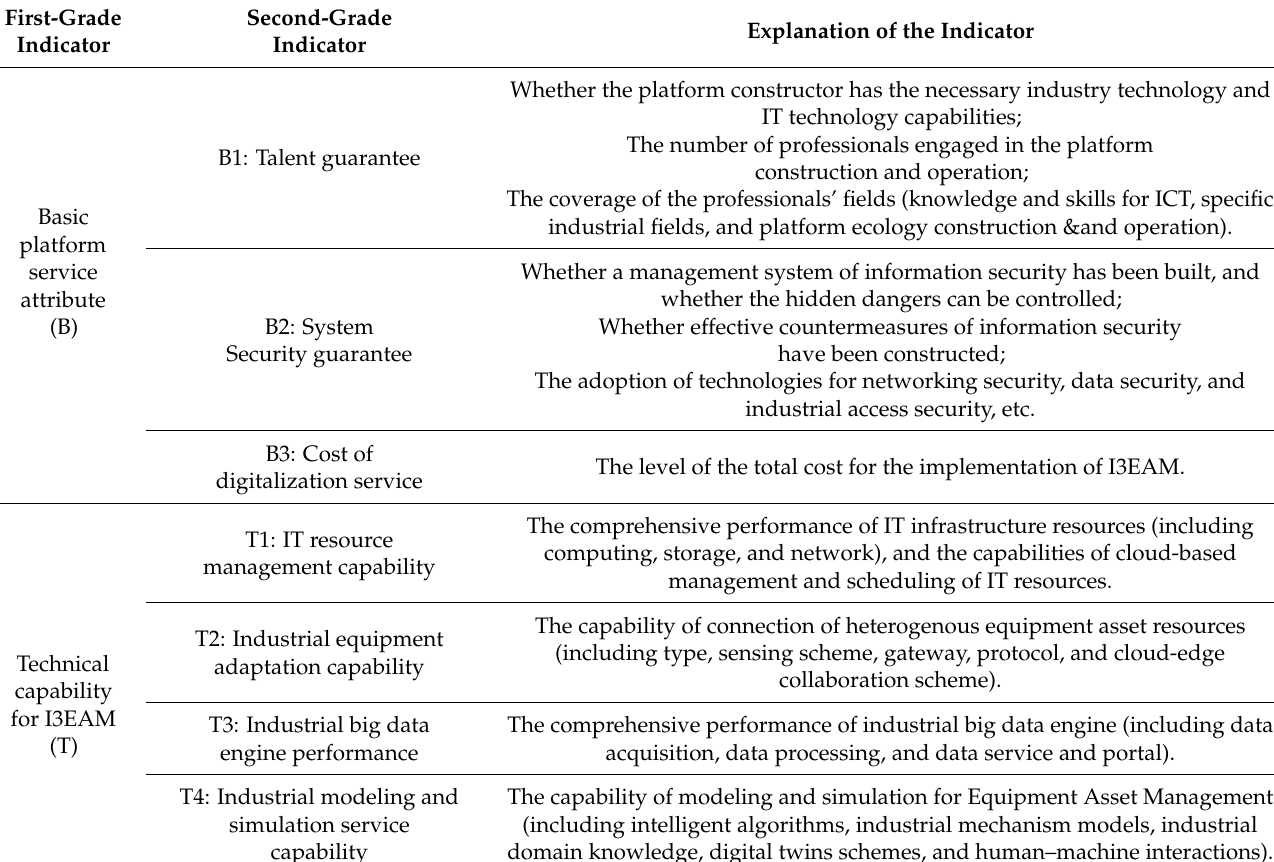
Table 3. Performance metric set for I3EAM